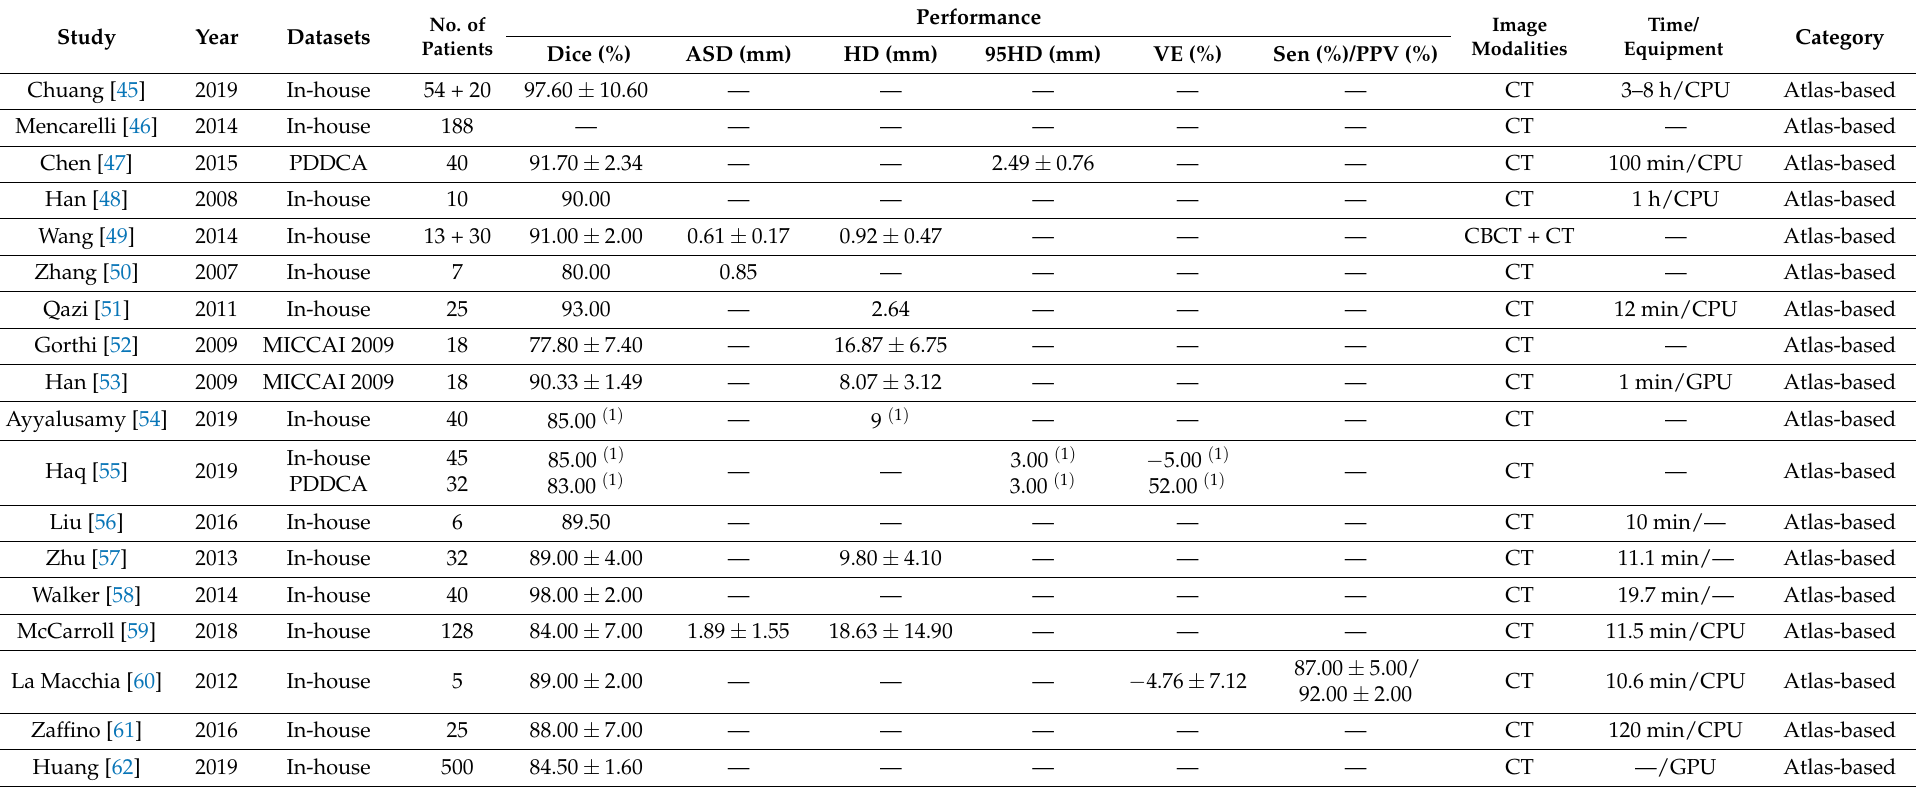
Table 4. Summary of atlas-based methods. ( 1 ) Values estimated from figures; actual values not